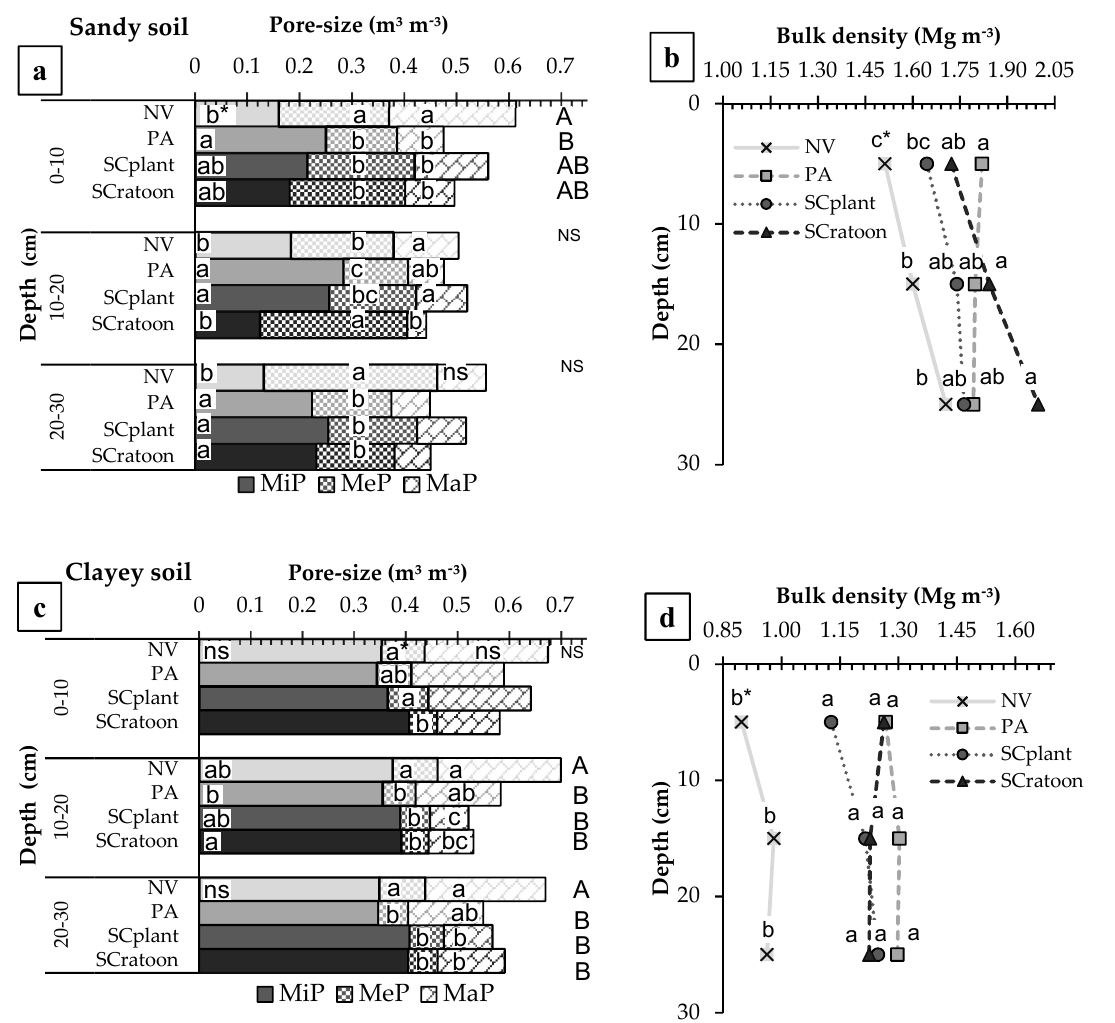
Figure 2. Soil pore-size distribution (microporosity (MiP) ≤ 15 µ m, mesoporosity (MeP) = 15–50 µ m, macroporosity (MaP) ≥ 50 µ m), total porosity ( a , c ), and bulk density ( b , d ) from 0–10, 10–20, and 20–30 cm layers under native vegetation (NV), pasture (PA), sugarcane plant (SCplant), and sugarcane ratoon (SCratoon) at Sandy soil ( a , b ) and Clayey soil ( c , d ). * Mean values within each site and each pore-size distribution in the same depth followed by the same letter do not di ff er among themselves according to Tukey’s test ( p < 0.05). ns Not